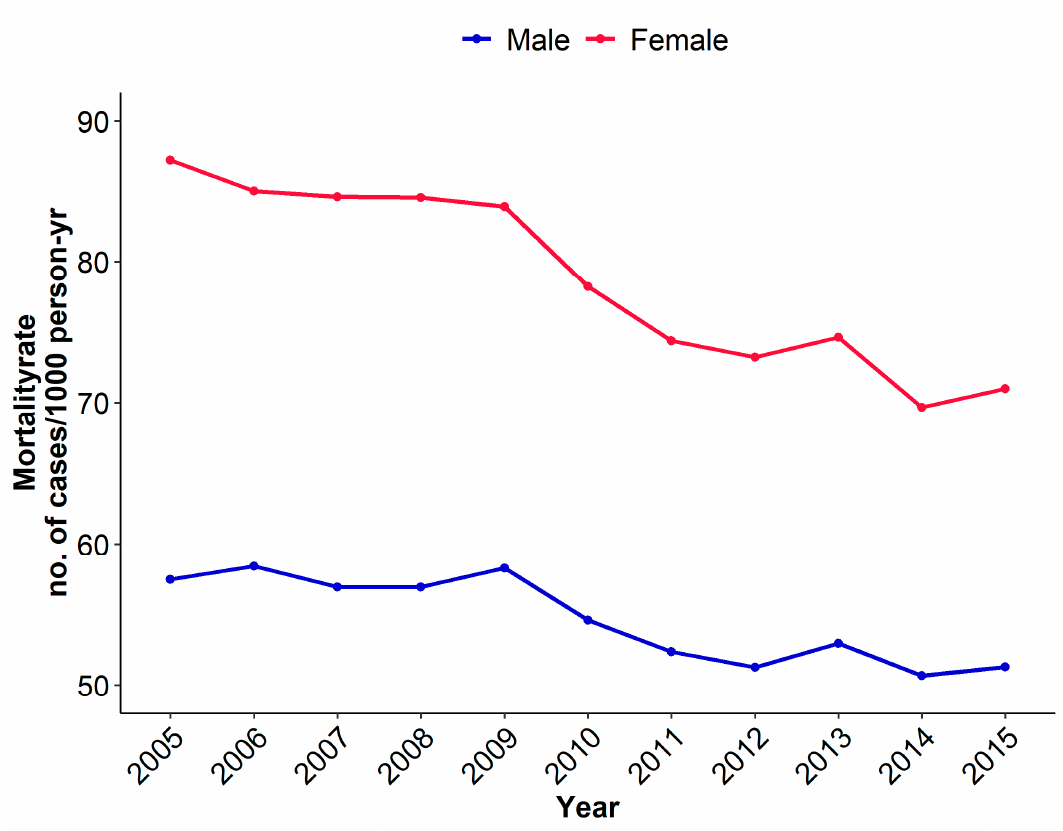
Figure 2. Incidence rates of inhospital mortality in cases per 1000 person years from 2005 to 2015, adjusted for age.